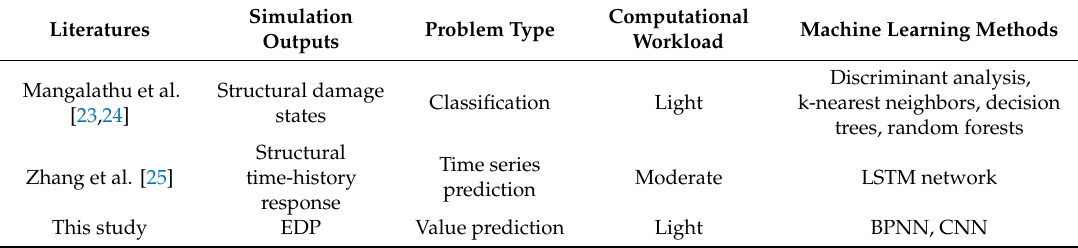
Table 1. Comparison of machine learning-based seismic response simulation methods. LSTM, long-short-term memory; BPNN, backpropagation neural network; CNN, convolutional neural network; EDP, engineering demand